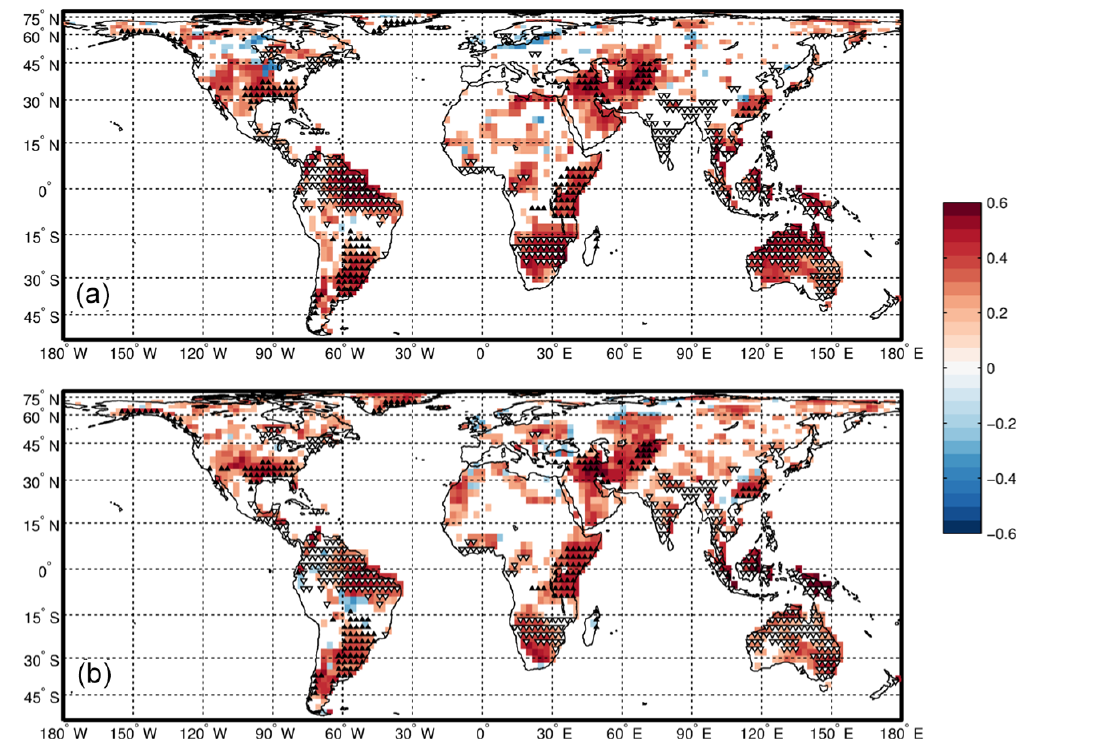
Figure 7. Point-by-point correlation of the first mode of variability in PRE forced by SM with (a) the total fields of PRE forced by ET and (b) the PRE forced by LAI. Data have been filtered using a cutoff low-pass filter at 1year − 1 frequency. Only areas where correlations passed a significance test at the 5% level are shown. Black upward (white downward) triangles denote areas with positive > 0.01 (negative < − 0.01) values of the first EOF of the PRE anomalies forced by the SM (Fig. 3c).